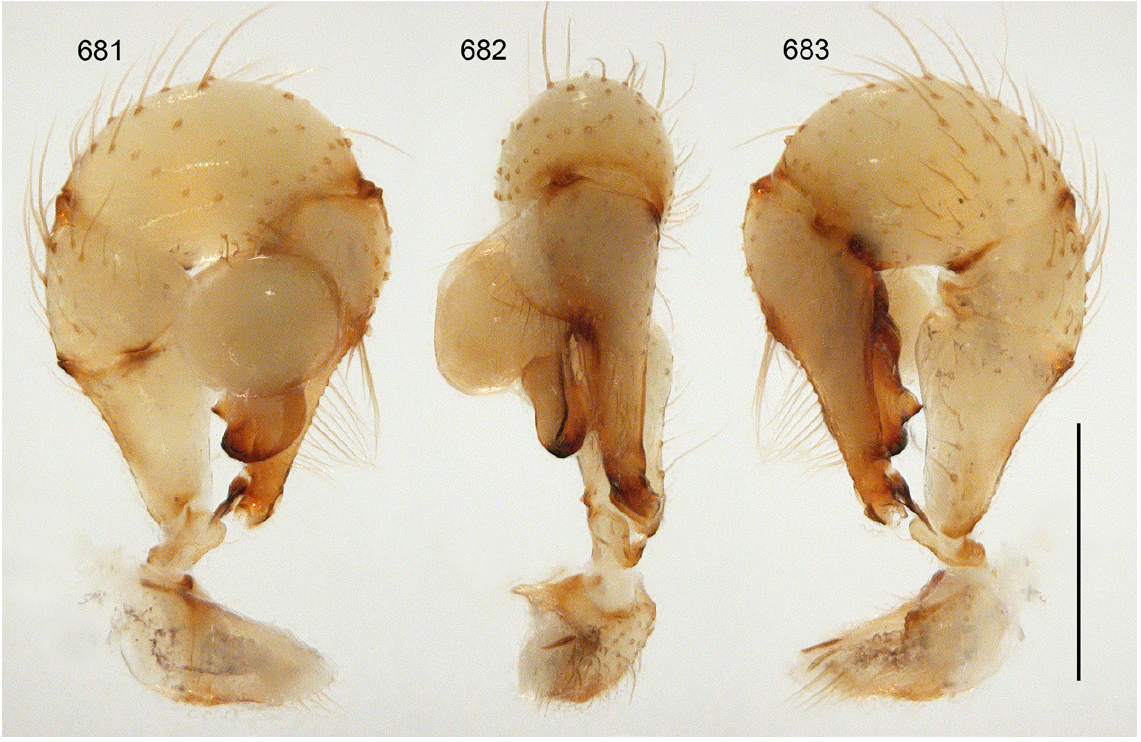
Figs 681–683. Crossopriza malegaon sp. nov.; holotype male from India, 17 mi NE of Malegaon (CAS); left palp, prolateral, dorsal, and retrolateral views. Scale bar = 0.5